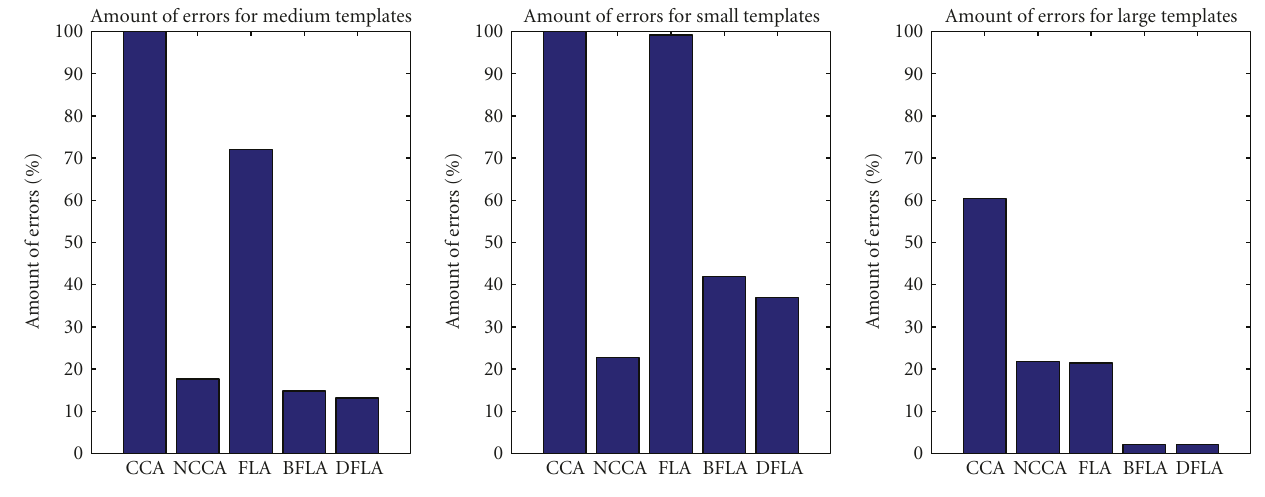
Figure 10: Amount of incorrect detected templates in percent for all images with regard to the size of the